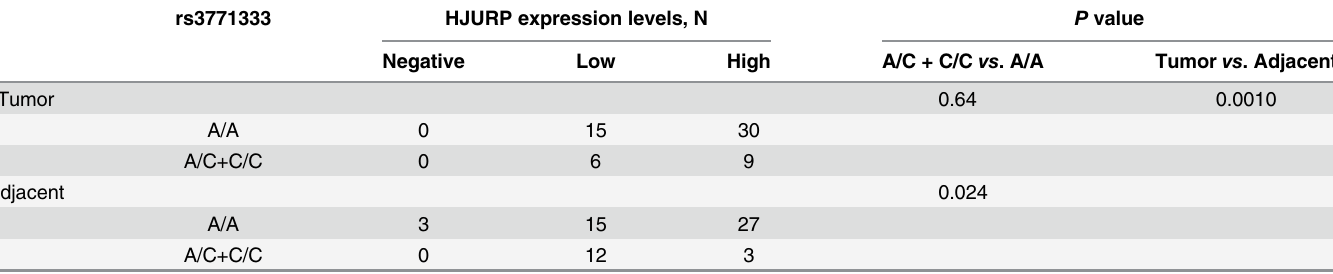
Table 4. Protein expression of HJURP by immunohistochemical staining in 20 HCC tissues and paired adjacent non-tumor tissues. rs3771333